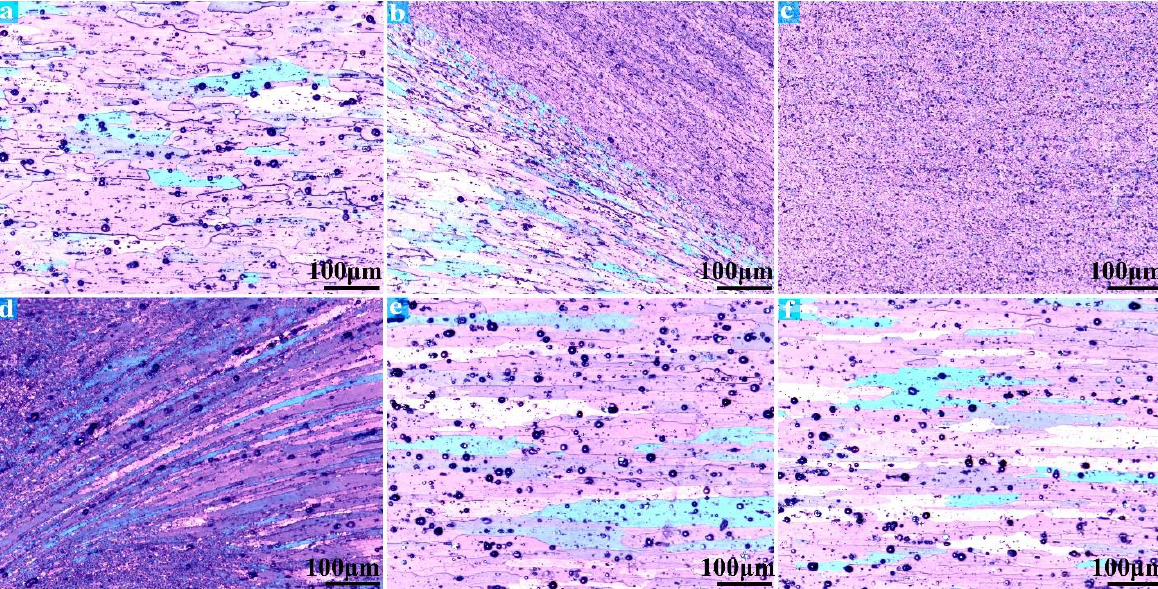
Figure 6 . OM images of the areas ( a - f) indicated on the hardness profile (Figure 5). c belongs to the AA6061 side in SZ.